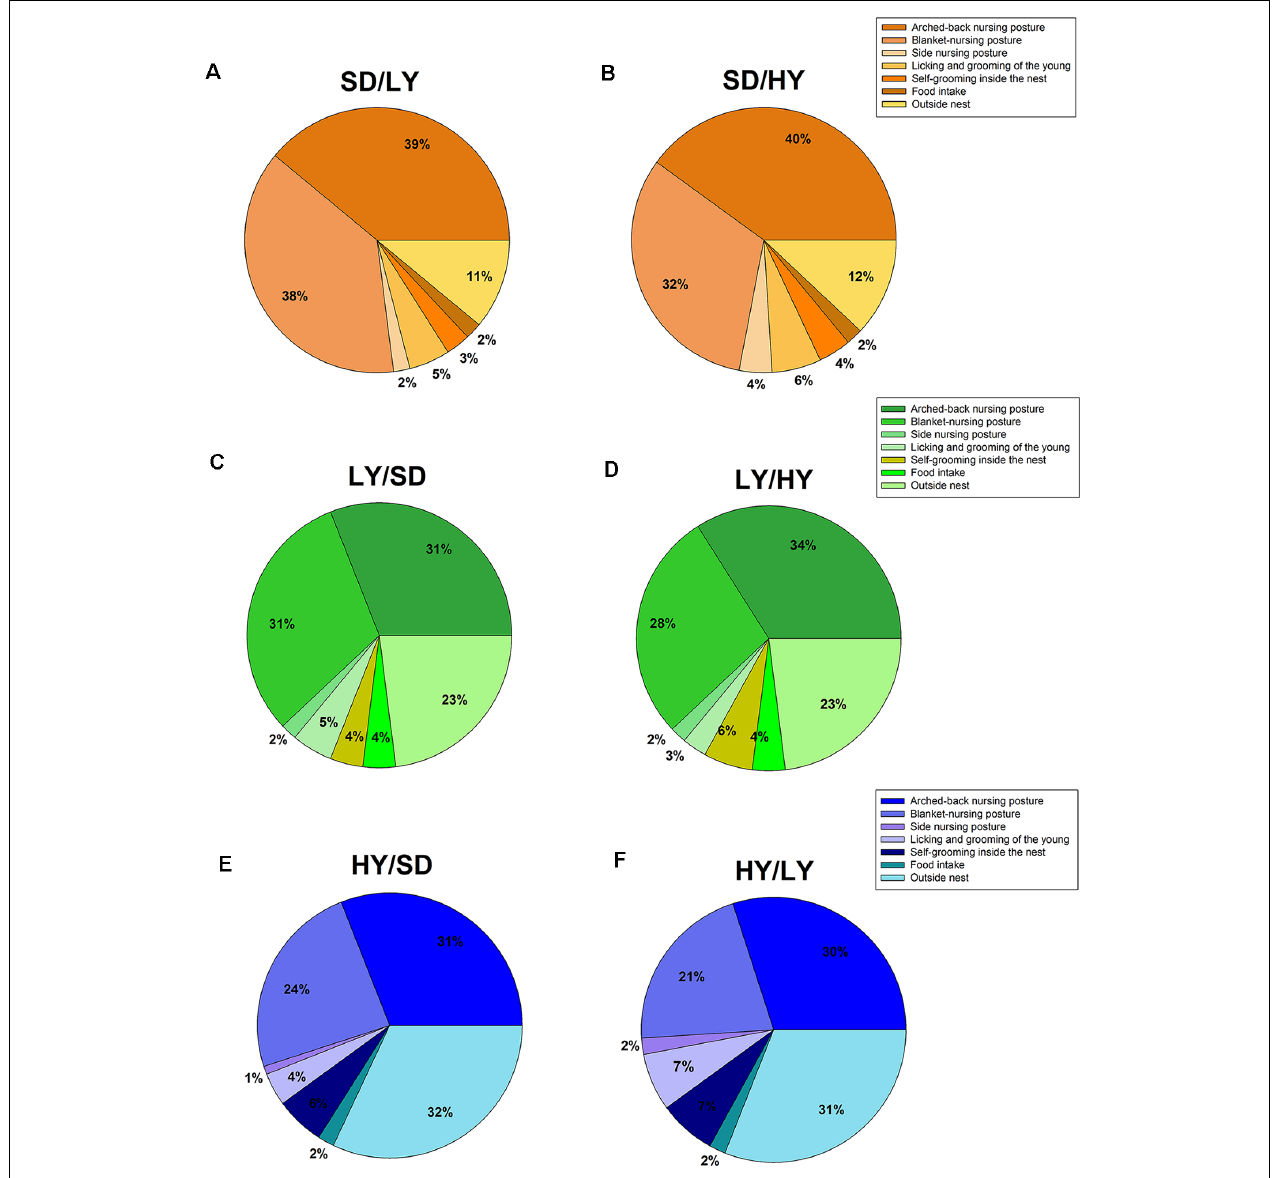
FIGURE 4 | Maternal care in cross-fostered male rats raised by HY or LY sublines or by SD dams. (A) SD dams that raised LY male rats (SD/LY) did not differ in their maternal behavior components. (B) SD dams showed an increase time spend outside the nest, but the difference was not significant (SD/HY). (C,D) LY dams showed a decreased frequency of the arched-back nursing posture compared to SD dams (SD/LY) or with respect to LY dams that raised HY male rats (LY/HY). (E,F) HY dams showed a lower proportion of blanket-nursing posture with respect to SD (HY/SD) or LY rats (HY/LY).